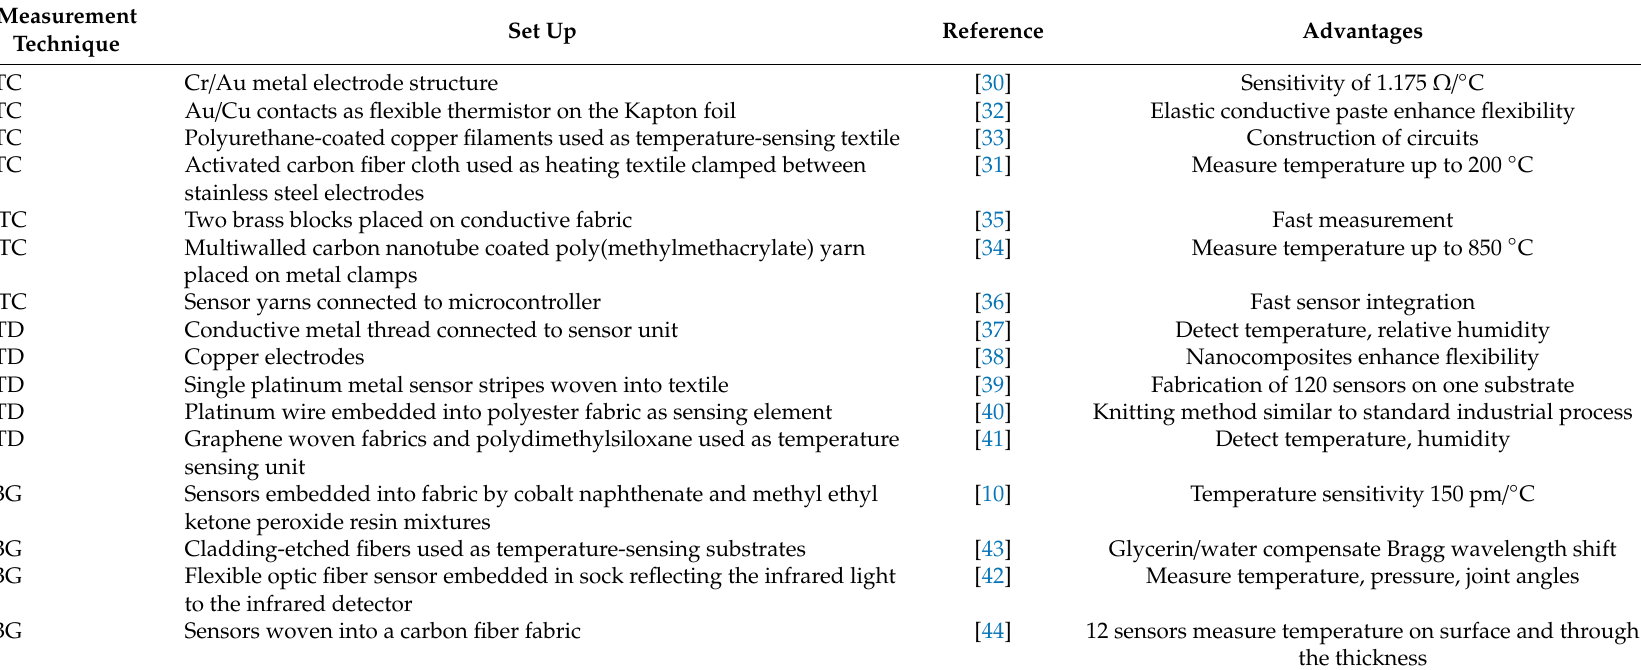
Table 2. Temperature measurement techniques in